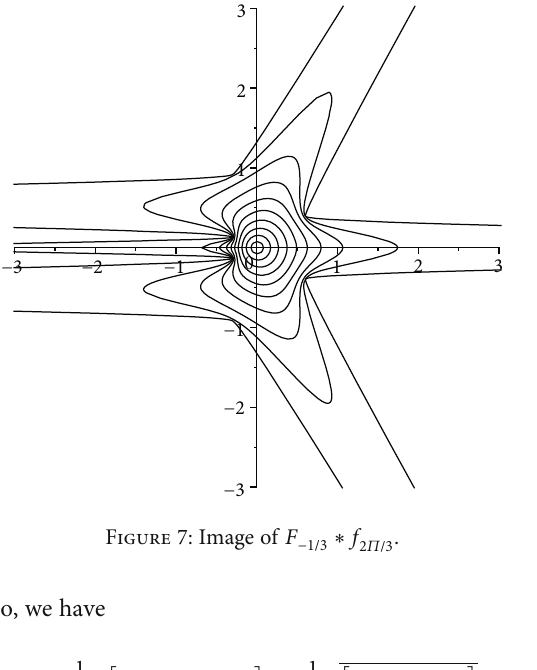
Figure 7: Image of F